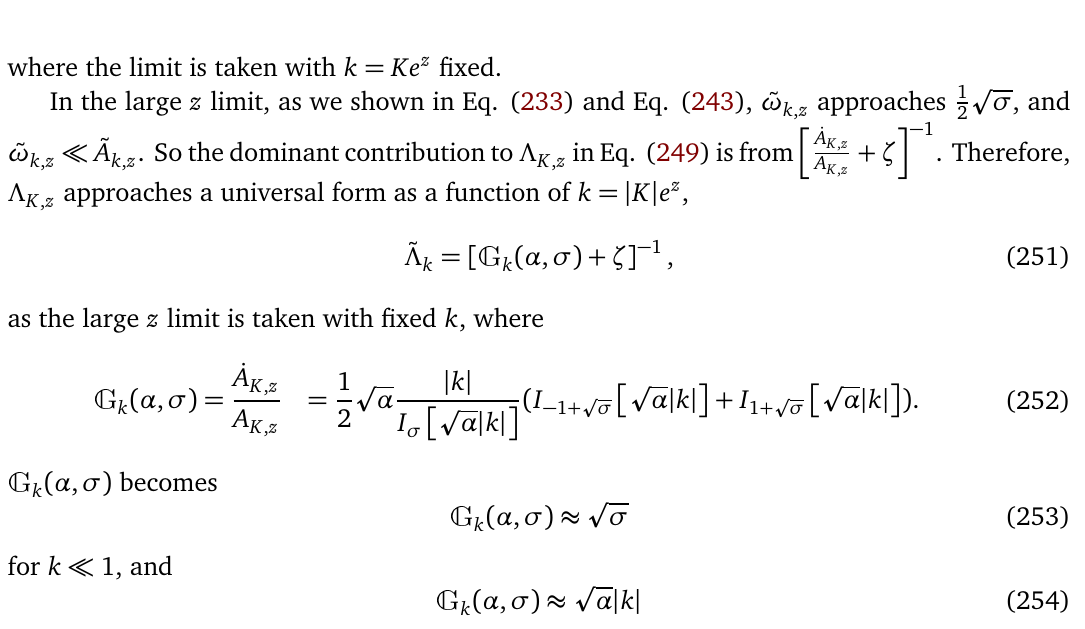
Figure 8: Λ plotted as a functions of K or z with α = 1 in D = 1. For (a), (b), (c), K , z we choose ζ = − 0.1 and σ = 2.01. For (d), (e), (f), we choose ζ = 0.1 and σ = 0.01. (a) Λ vs z at K = 0.001 (blue), 0.005 (orange), 0.01 (green), 0.05 (red) and 0.1 K , z Λ (purple). (b) Λ vs K at z = 2 (blue), 3 (orange), 4 (green), 5 (red). (c) d vs K , z K , z dz z for K = 0.001, K = 0.005 and K = 0.01. For each value of K , the minimum occurs at z = 7.82184, z = 6.2124 and z = 5.51925, respectively. At all minima, Ke z takes the same value, 2.49448. (d) Λ vs z at K = 0.001 (blue), 0.005 (orange), 0.01 K , z (green), 0.05 (red) and 0.1 (purple). (e) Λ vs K at z = 2 (blue), 3 (orange), 4 K , z Λ (green), 5 (red). (f) d vs z for K = 0.001, K = 0.005 and K = 0.01. For each K , z dz value of K , the minimum is located at z = 6.47645, z = 4.86718 and z = 4.17465. At all minima, Ke z takes the same value,